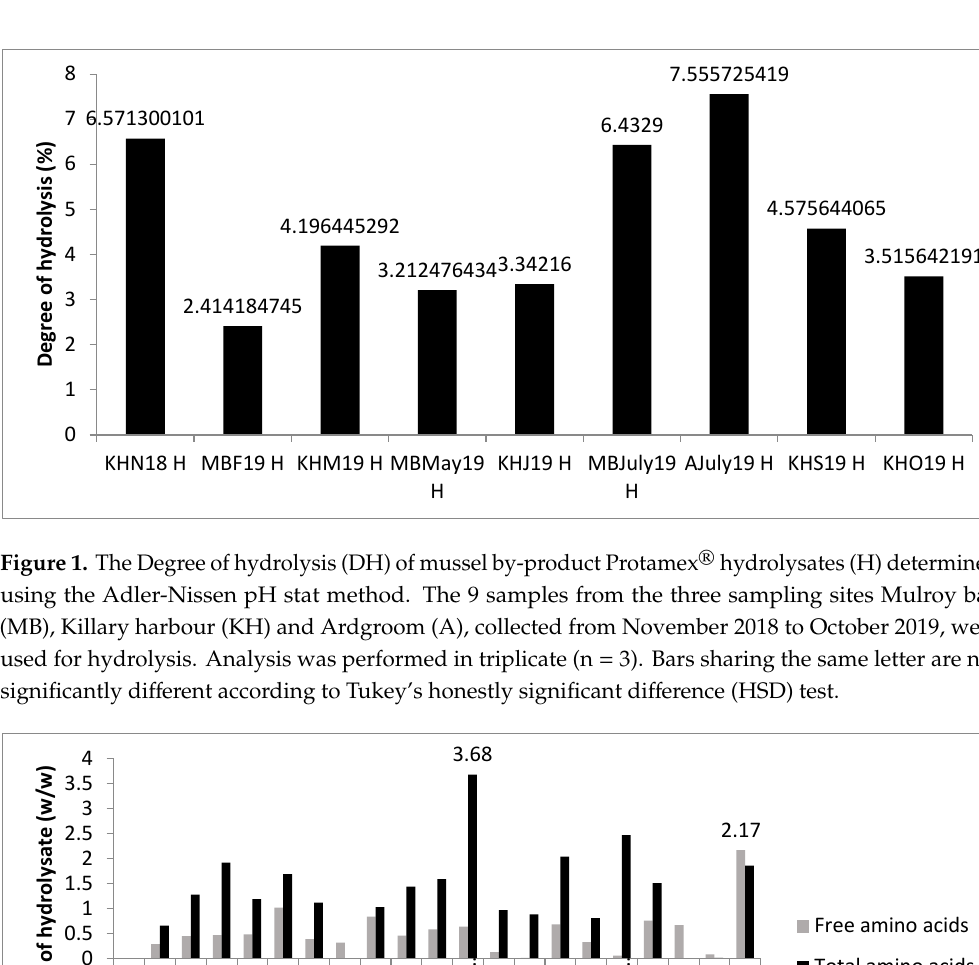
Mulroy bay (MB), Killary harbour (KH) and Ardgroom (A), collected from November 2018 to October 2019, were used for hydrolysis. Analysis was performed in triplicate (n = 3). Bars sharing the same letter are not significantly different according to Tukey’s honestly significant difference (HSD) test.